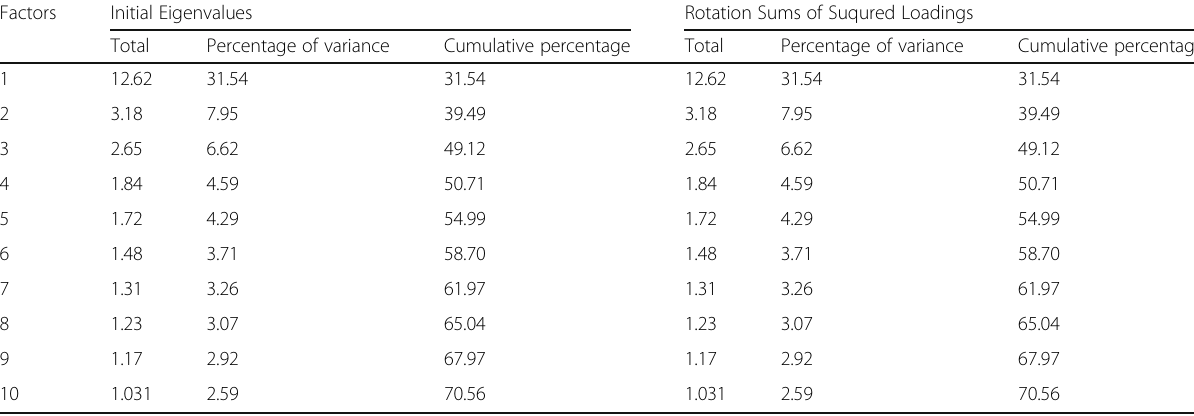
Table 2 Percentage of variance explained by extracted factors after Varimax rotation Factors Initial Eigenvalues Rotation Sums of Suqured